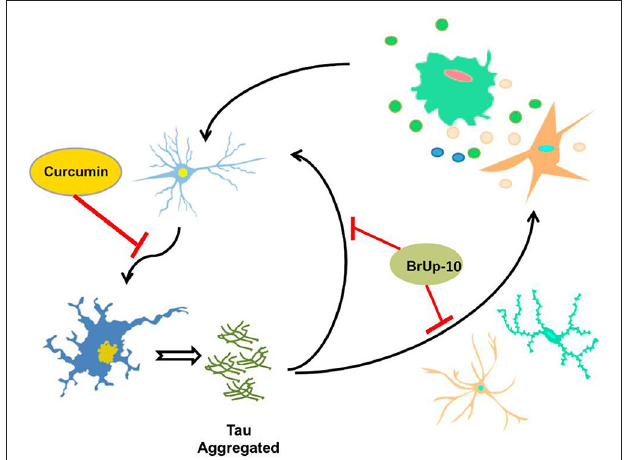
FIGURE 2 | τ aggregates potentiate the neuroinflammatory process . Activated microglia and astrocytes, induce neuronal death through neuroinflammatory process, allowing the release of τ protein aggregates from the dead neuron. These aggregates of τ are capable of inducing activation of microglia and astrocytes, as well as neuronal death, thus producing a circuit of constant neuroinflammation. Considering the possible protective effects of curcumin, neuronal death could be delayed or inhibited by this compound, halting this circuit of neuroinflammation. Furthermore, the nutraceutical complex Brain Up-10 acts on τ aggregates, and may prevent neuronal death and activation of microglia and astrocytes, stopping the circuit and the development of